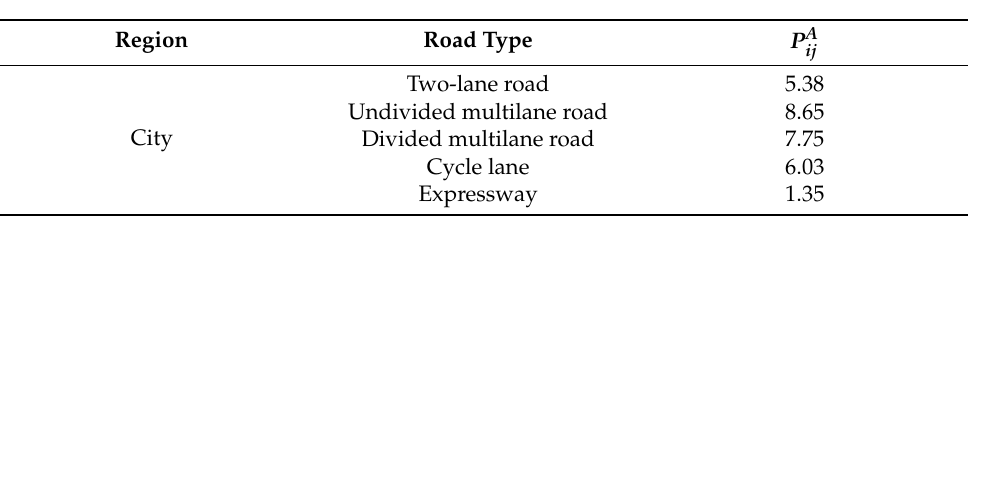
Table 1. Weighted average truck accident probability (accidents per million vehicle/km) in three states of the United